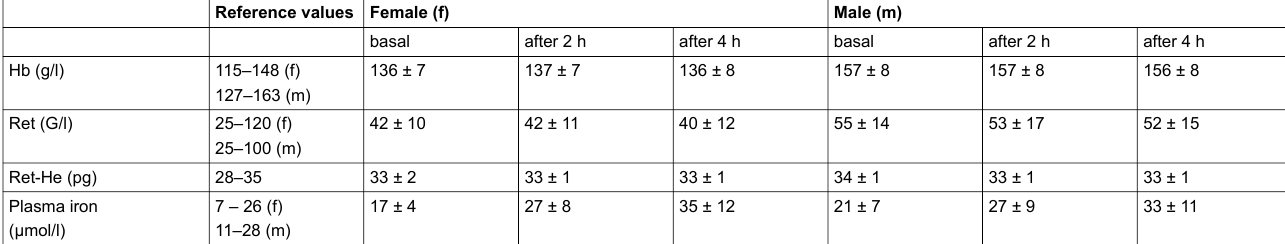
Table 2: Laboratory findings before and after ingestion of ferrous